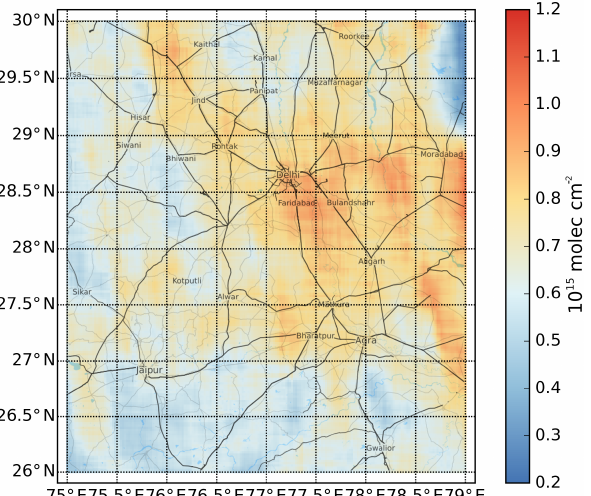
Figure 12. Oversampled distribution of OMI vertical HCHO columns (10 15 moleccm − 2 ) around Delhi. The underlying road network is reproduced with permission from © www.thunderforest. com (map) and from © www.osm.org/copyright (data).